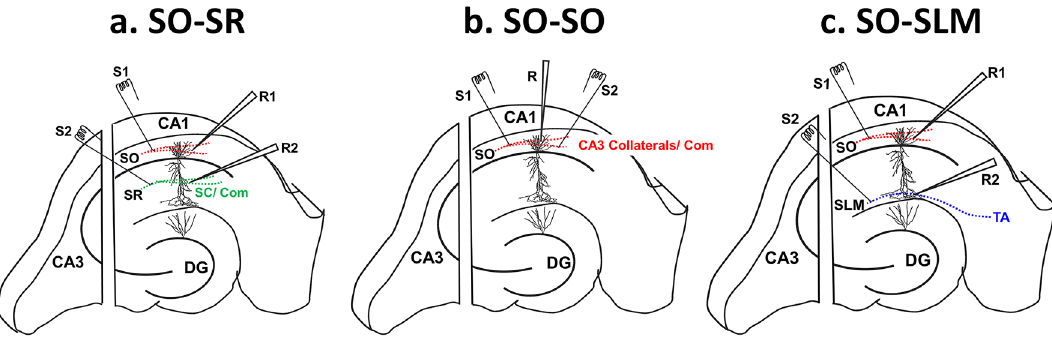
Figure 1. A Simplified schematic diagram of the hippocampus representing electrode placement in SR, SO and SLM. ( a ) SO-SR electrode placements. S1 and S2 represent stimulating electrodes, and R1 and R2 represent recording electrode placement in SO and SR, respectively. ( b ) SO-SO electrode placements. S1 and S2 represent the stimulation electrode placement on opposite ends in SO, while R represents the recording electrode placed at the centre of S1 and S2 (see Supplementary Fig. S1 for the test of pathway independence in SO). ( c ) SO-SLM electrode placements. S1 and S2 represent stimulating electrodes, and R1 and R2 represent recording electrode placements in SO and SLM, respectively. The pyramidal neuron image shows its processes extending from stratum pyramidale (SP) towards SR (apical dendrites) and SO (basal dendrites). (Com, commissural fibers; SC, Schaffer collaterals; TA, temporoammonic input; DG, dentate